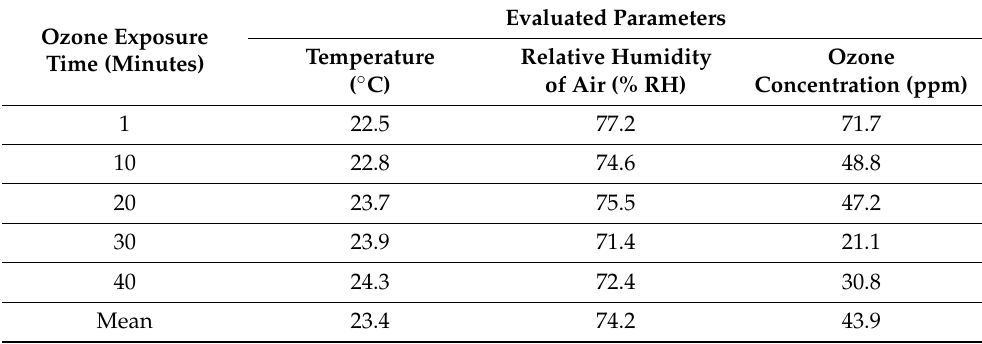
Table 1. Monitoring ozone concentration, temperature, and humidity of different bacterial strains after exposure to ozone. Evaluated Parameters Ozone Exposure Temperature Relative Humidity Ozone Time (Minutes)